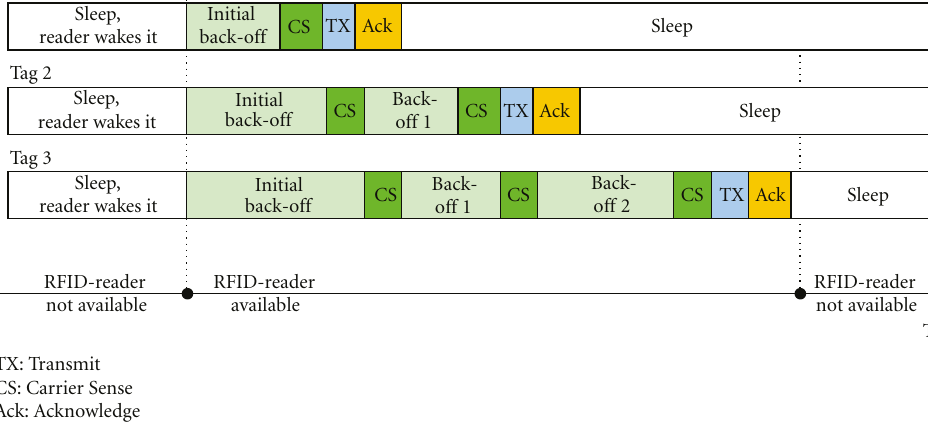
Figure 6: Tags delivering their payload packets to a reader.